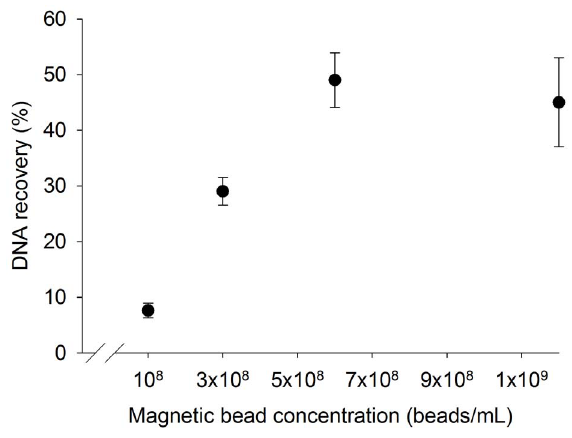
Figure 9. The percentage of DNA recovered from 1 mL urine samples increases as the concentration of magnetic beads increases to 6 6 10 8 beads/mL (mean 6 s.d., n=3).